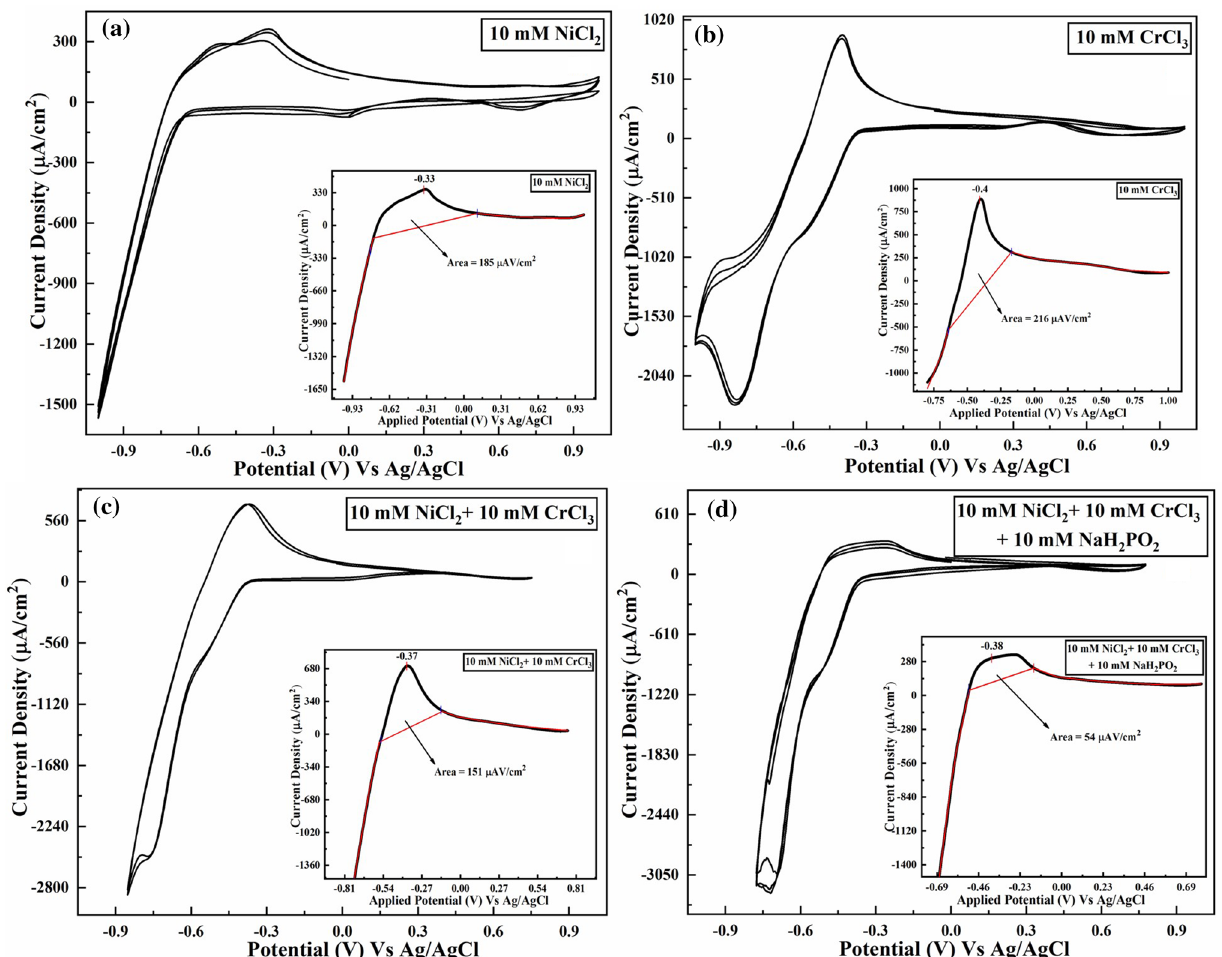
Fig. 1 Cyclic voltammograms of a 10 mM CrCl 3 , b 10 mM NiCl 2 , c 10 mM CrCl 3 and 10 mM NiCl 2 , and d combination of 10 mM CrCl 3 , 10 mM NiCl 2, and NaH 2 PO 2 aqueous solution at scan-rate of 10